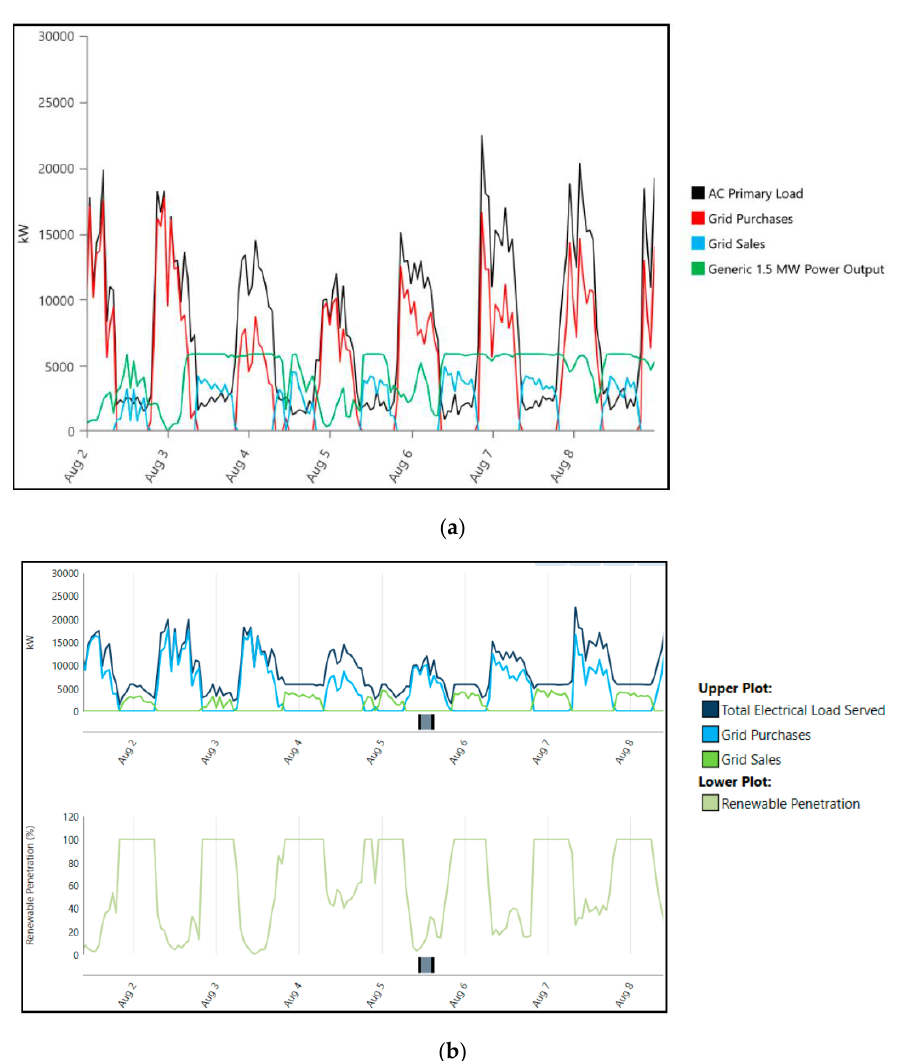
Figure 8. ( a ) One-week generation of the grid along with wind energy, ( b ) System performance with RE